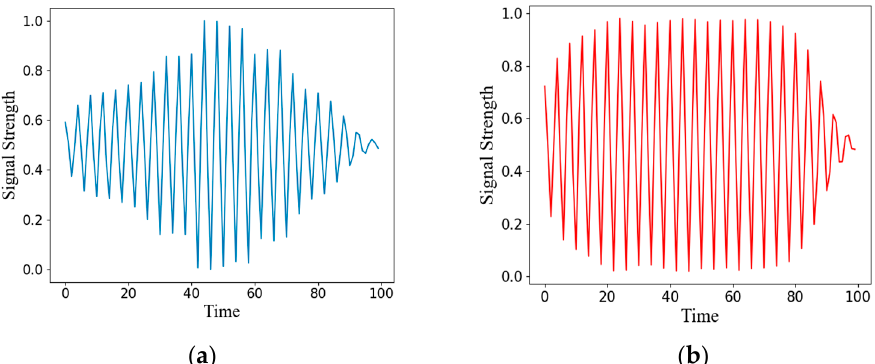
Figure 7. Anomaly and reconstructed signal: ( a ) Original signal of an anomaly; ( b ) Reconstruction signal of anomaly.